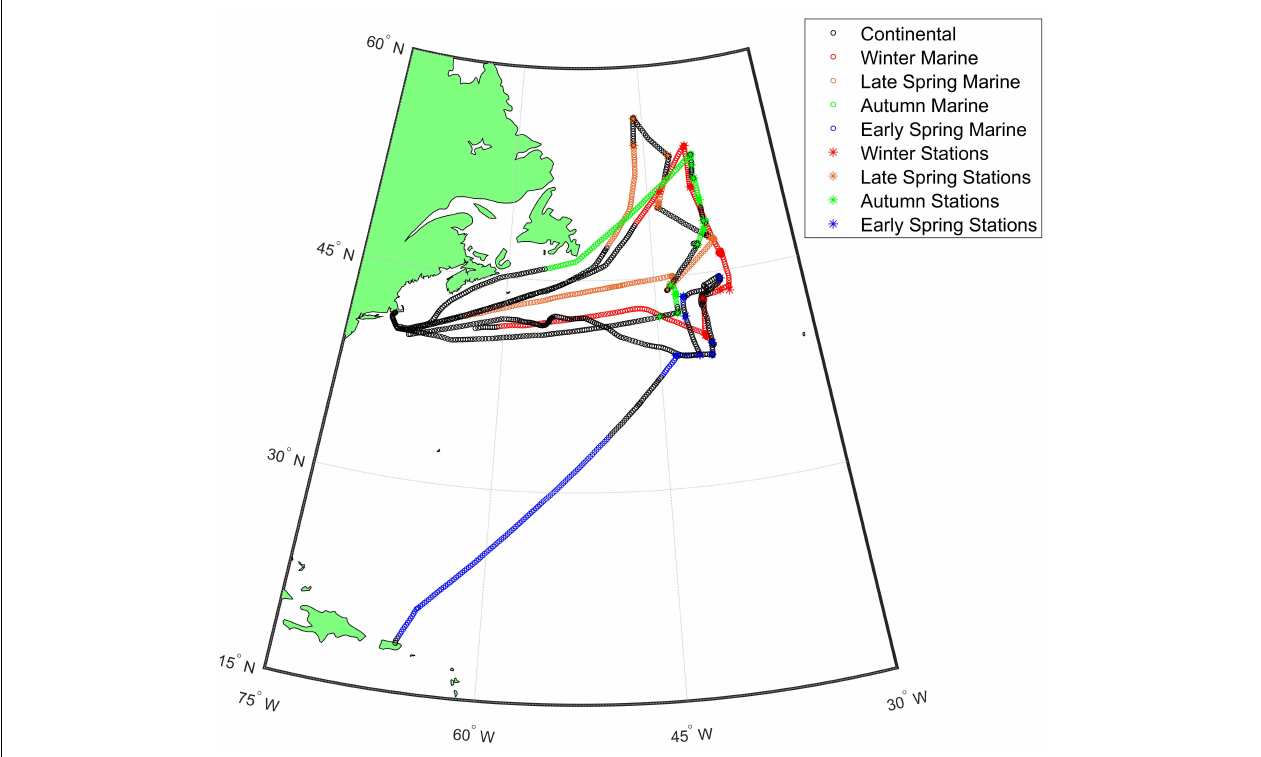
FIGURE 1 | Map of the NAAMES study region with intensives sampling locations indicated with asterisks. The air mass categories are shown for each cruise with continental air masses (black) and marine air masses [Winter (red), Late Spring (orange), Autumn (green), and Early Spring (blue)]. The Winter, Late Spring, and Autumn cruises departed from Woods Hole, MA and the Early Spring cruise departed from San Juan, Puerto